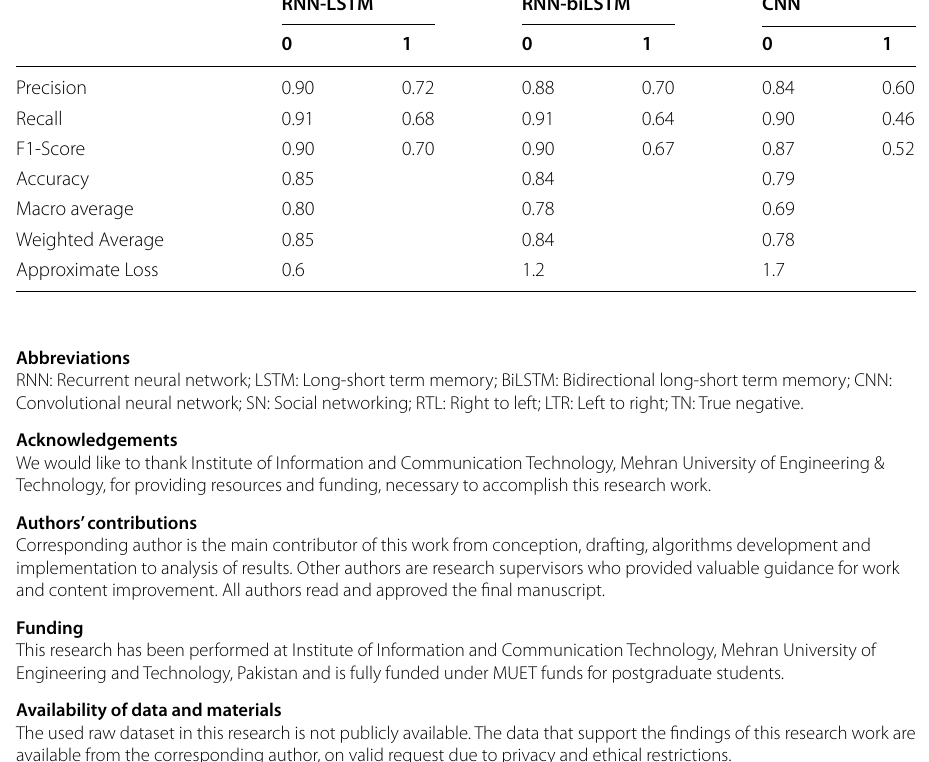
Table 2 Evaluation Measures for Implemented Models Evaluation